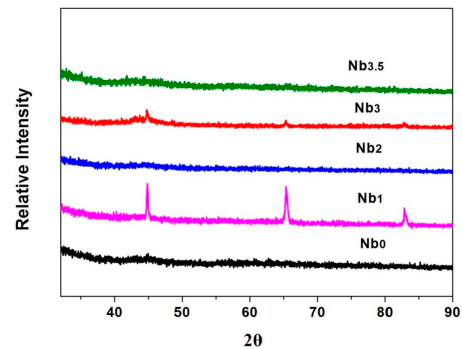
Figure 5. X ‐ ray diffraction patterns of Fe 76.5 − x Cu 1 Nb x Si 13.5 B 9 ( x = 0, 1, 2, 3, 3.5) fibers.